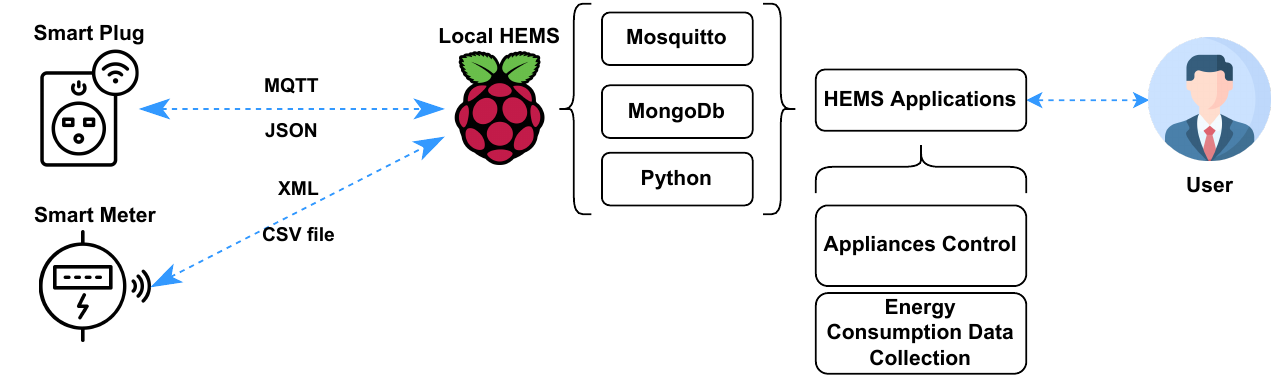
Figure 5. Schematic diagram for local HEMS